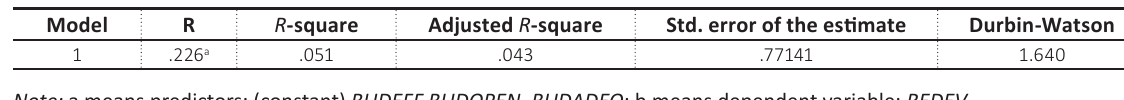
Table 5. Model summary b